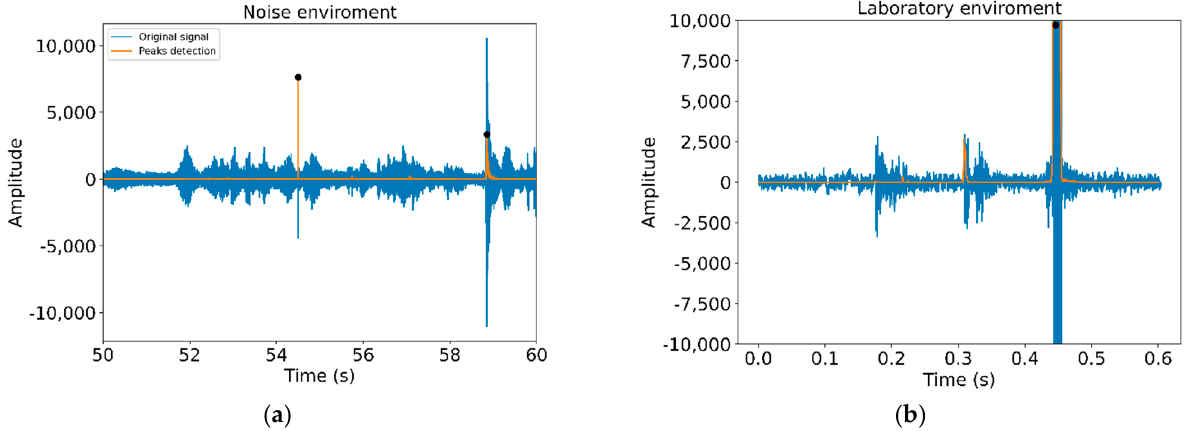
Figure 6. Noise level measured: ( a ) connection of a Dimmer in the production line (with noise), ( b ) connection of an RJ45 connector in a laboratory environment (without noise).